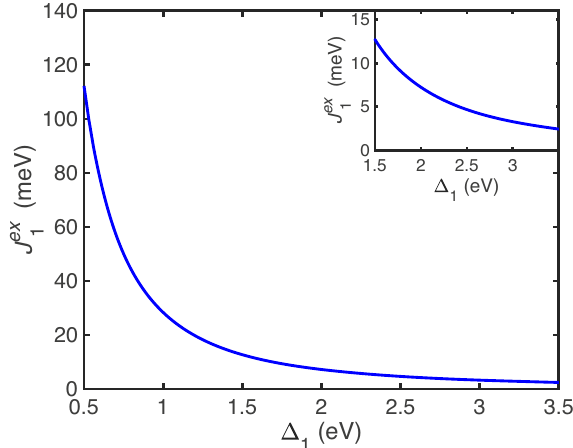
as a function of Δ 1 with Δ 2 = 5 eV, Δ CF = 2.5 eV, 1